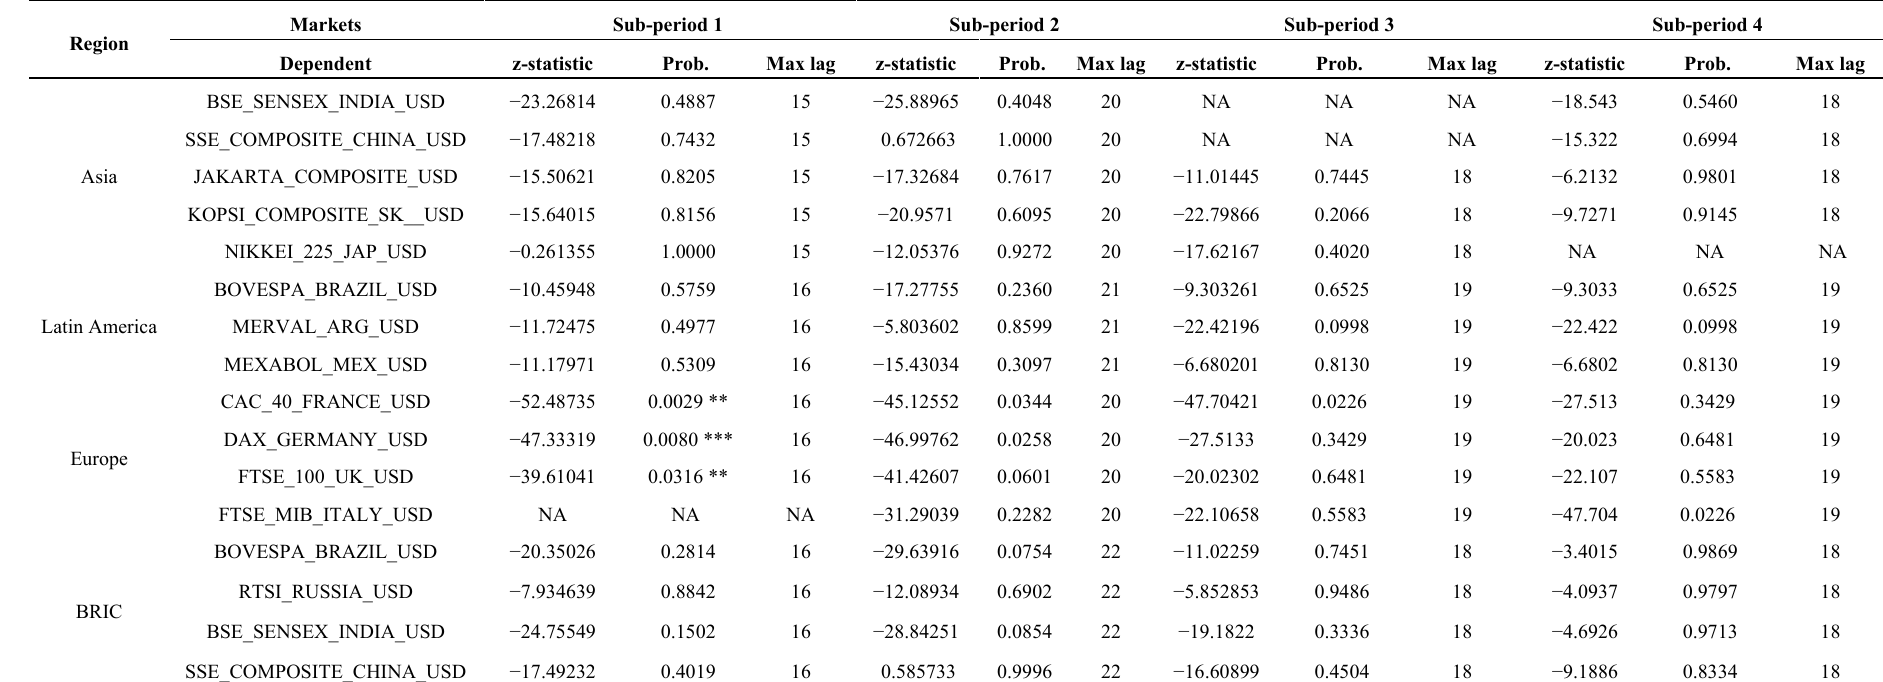
Table 5. Test for Possible Regional